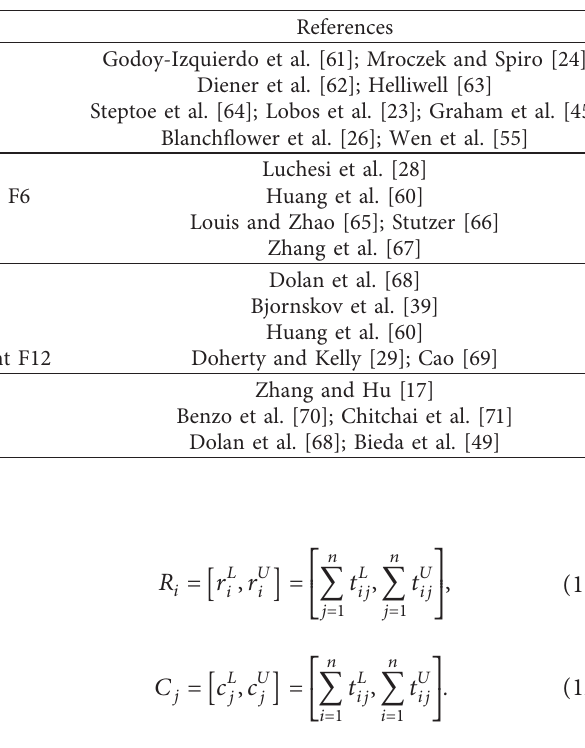
Table 1: Evaluation system of influencing factors of land-lost farmers’